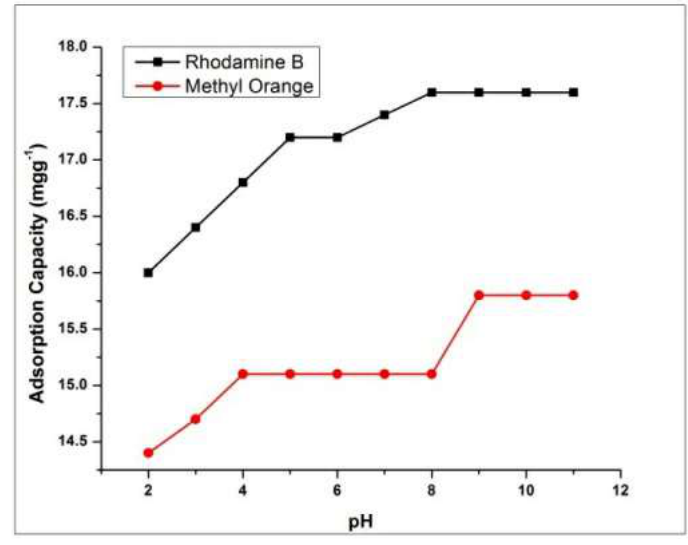
Figure 12. Effect of pH on dyes adsorption.